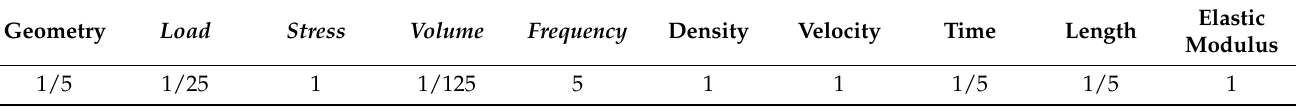
Table 3. Scale factors of the dynamic model test.